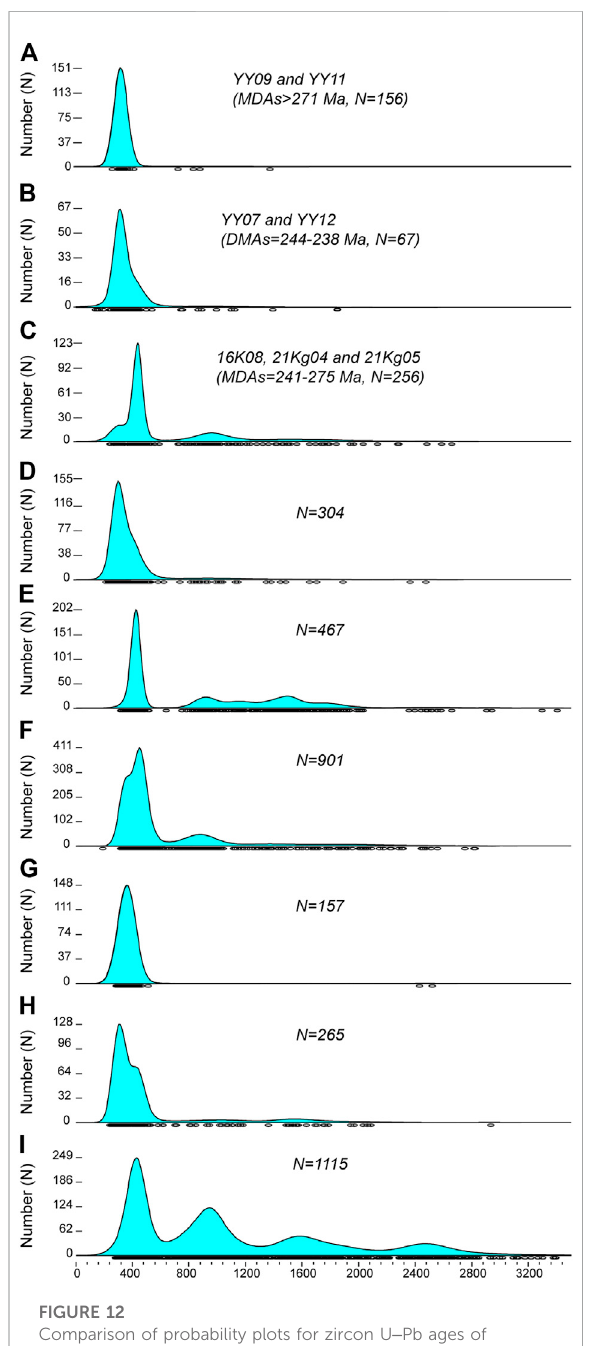
FIGURE 12 Comparison of probability plots for zircon U ‒ Pb ages of sedimentary rocks around the KGSC. (A) The sandstone matrix (MDAs > ca. 244 Ma, Samples YY09 and YY11) in the KGSC in the northern HL area. (B) The sandstone matrix (MDAs ≤ ca. 244 Ma, Samples YY07 and YY12) in the KGSC in the northern HL area. (C) The sandstone matrix in the KGSC in the southern HL area. (D) The sandstone matrix (MDAs = 243 – 243 Ma) in the KGSC in the northern HL area (Ao et al., 2021). (E) The sandstone matrix (MDAs = 384 – 315 Ma) in the KGSC in the Yamansu area (Chen et al., 2019). (F) Sedimentary rocks in the Harlik arc. (G) Devonian- Permian sedimentary rocks of the Dananhu arc (Chen et al.,